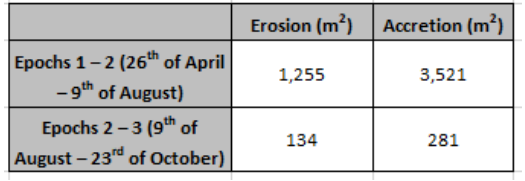
Table 7: Accretion and erosion between epochs